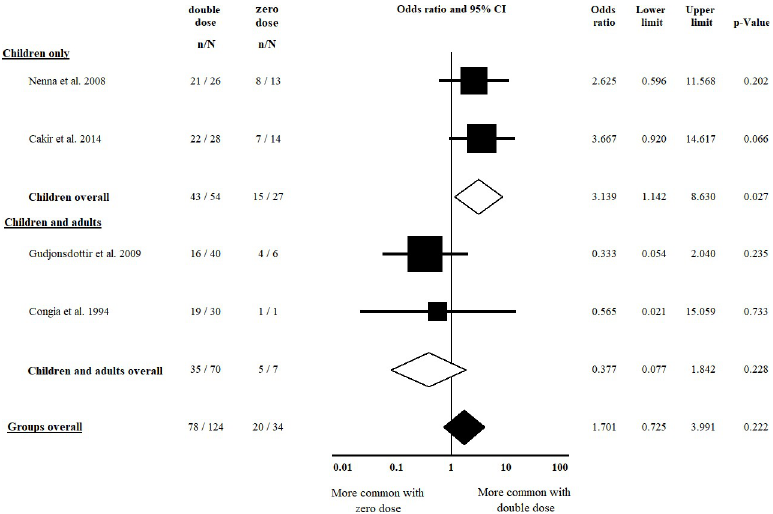
Fig 3. Odds ratios of classical presentation of CD at diagnosis with double dose vs. zero dose of HLA-DQB1 � 02. A significant gene dose effect was detected in the subgroup of children. Heterogeneity of the groups overall: I 2 = 40.7%, p = 0.168; heterogeneity of the subgroup of children: I 2 = 0.0%, p = 0.747. CI: confidence interval.